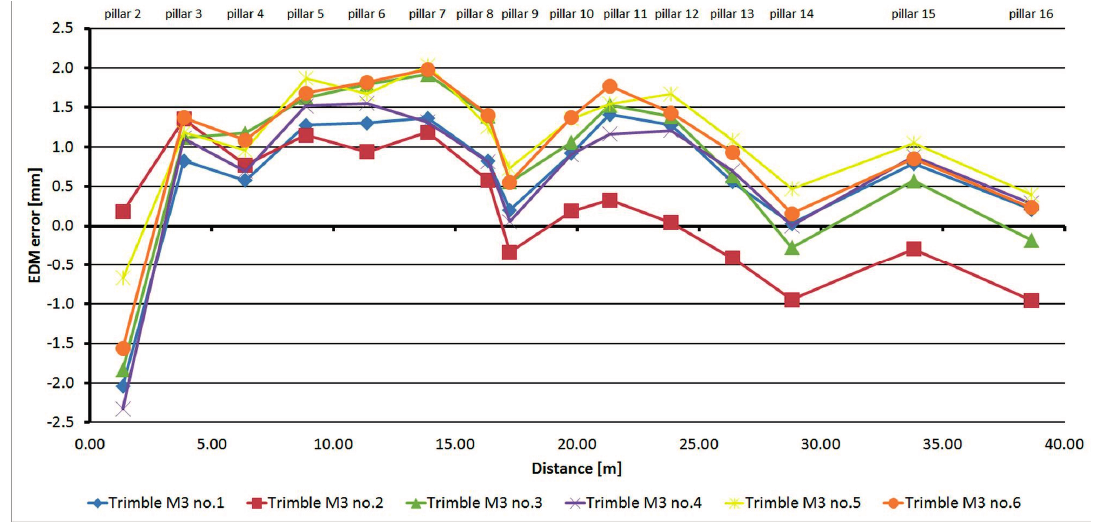
Figure 24. Comparison of absolute errors of six Topcon GPT-7501 instruments.